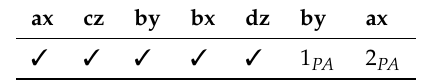
Table 6. MR-I results for participation constraints